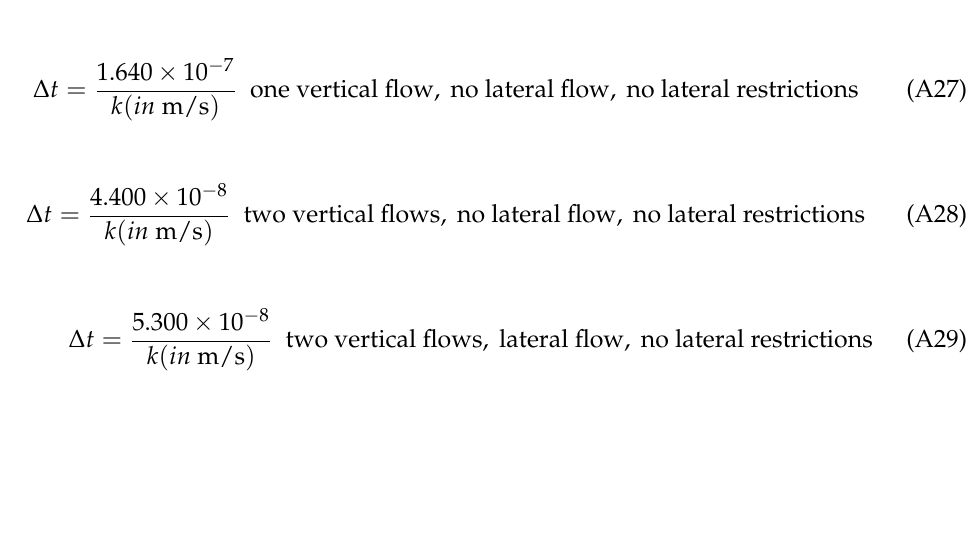
Figure A4. Calibration curves of the elastoplastic coupled model under vertical flow, lateral flow, and no lateral